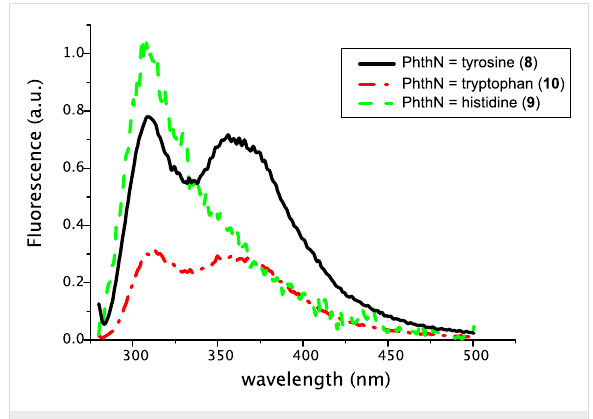
Figure 4: Fluorescence spectra of compounds 8 – 10 ( c = 6 × 10 − 5 in CH 3